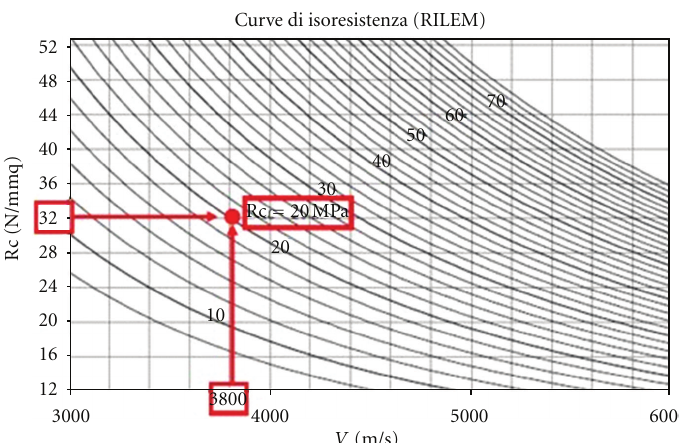
Figure 3: Example of isoresistance curves—RILEM NDT 4 recommendations.